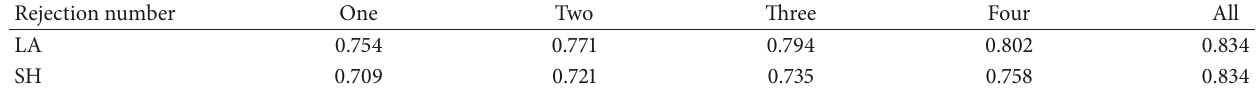
Table 6: Prediction accuracy of logistic regression.